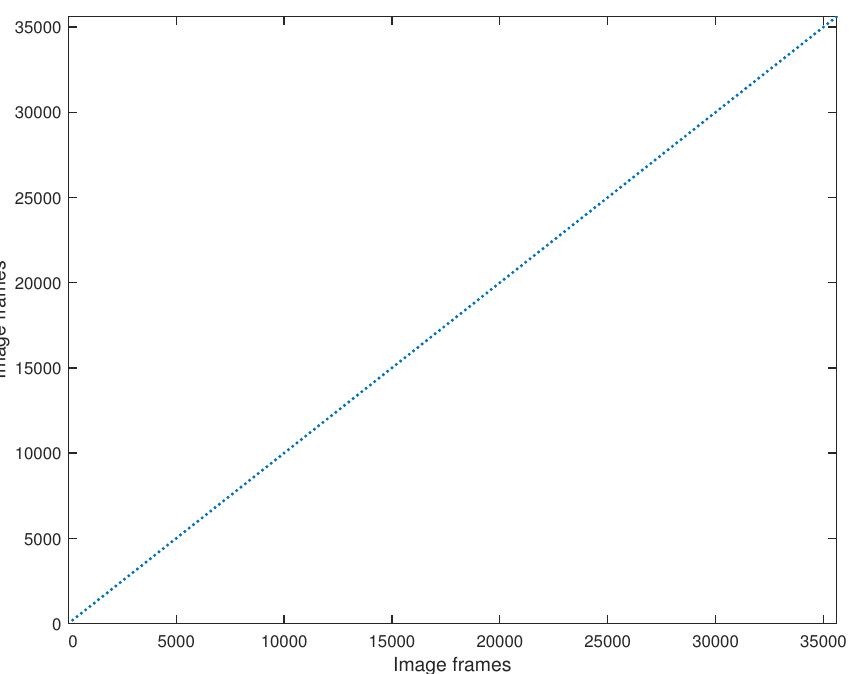
Figure 7. Ground truth. Since the frame from one season corresponds to the same frame in any of the other three seasons, the ground truth is